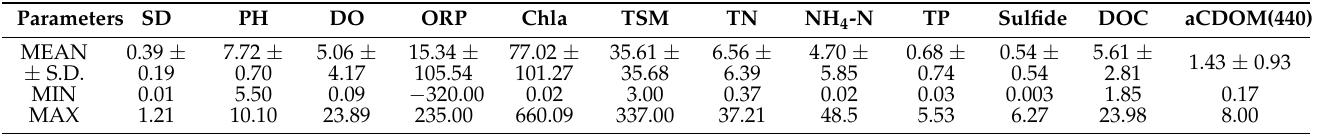
Table 1. Values of 12 water quality parameters in the in-suit dataset.